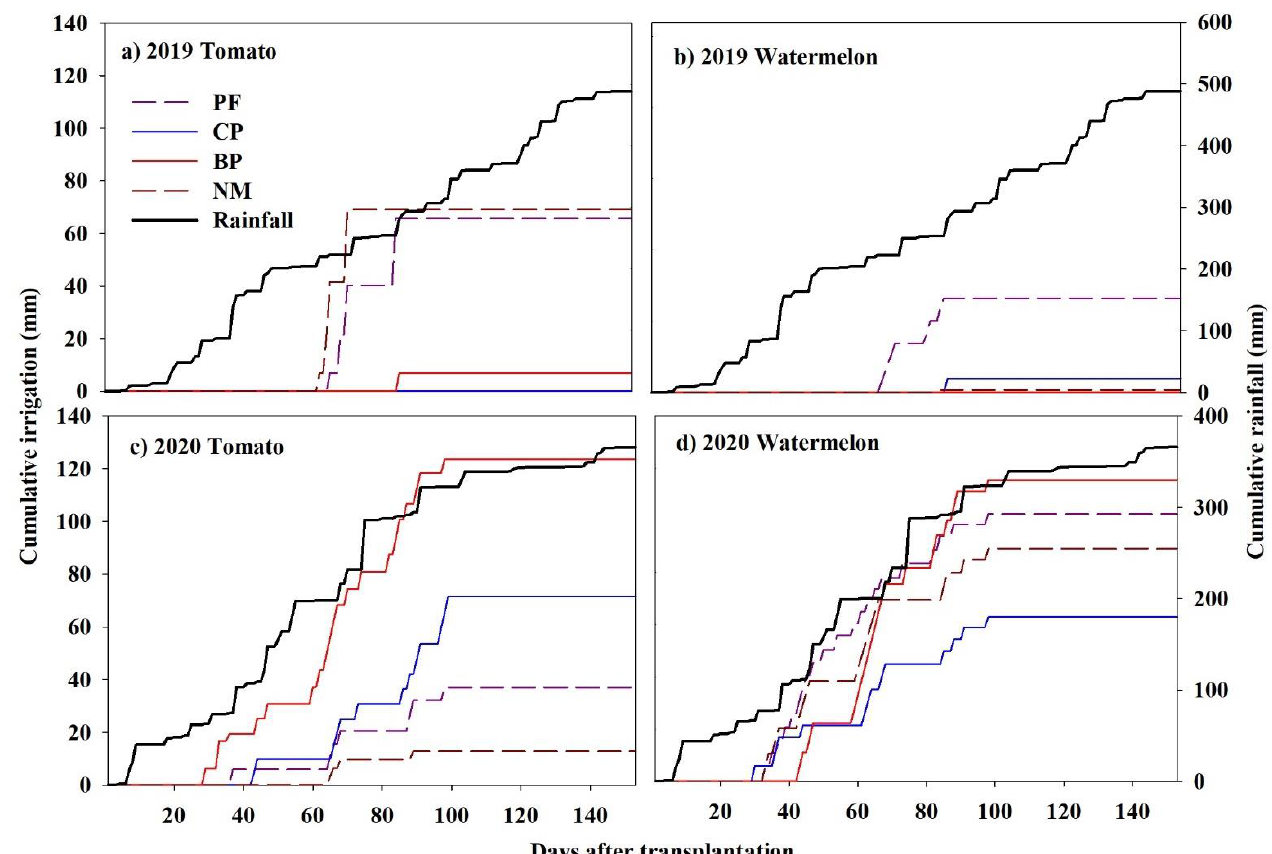
Figure 7. Monthly cumulative rainfall (mm) with cumulative irrigation amounts for fabric landscape (PF), clear plastic (CP), black plastic (BP), and no mulch (NM) during two-year field experiments with ( a ) 2019 tomato, ( b ) 2019 watermelon, ( c ) 2020 tomato, and ( d ) 2020 watermelon.